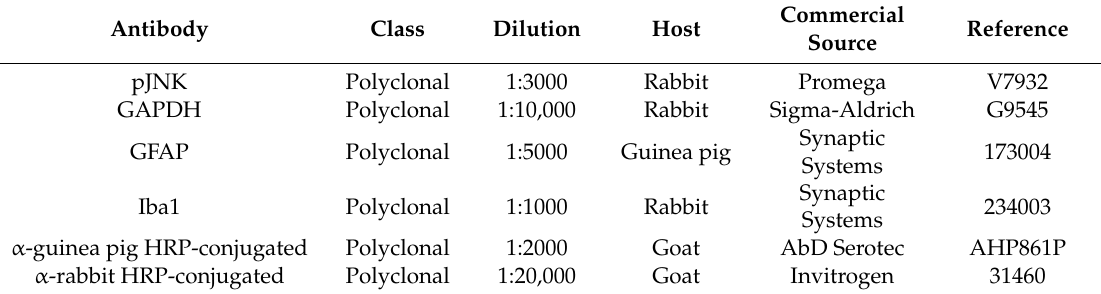
Table 4. Antibodies used for Western